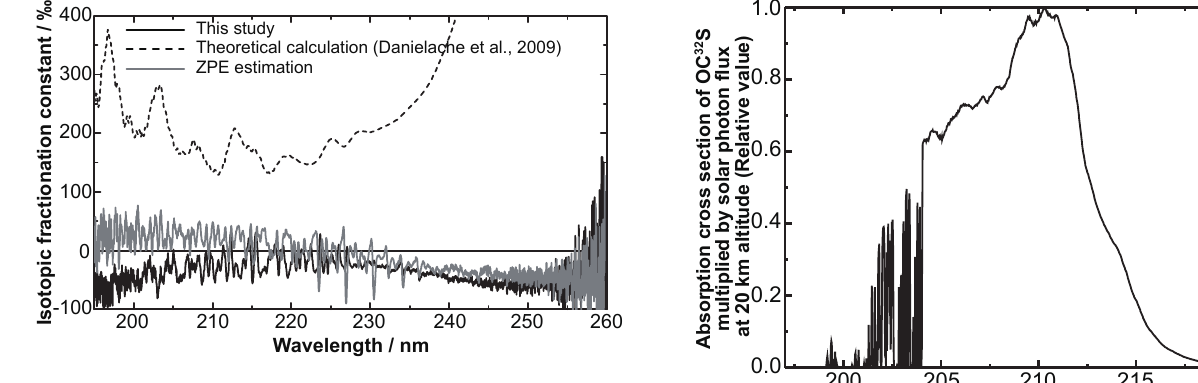
Fig. 5. Carbon isotope fractionation constant ( 13 ε ( λ )) calculated from Eq. (6) as a function of wavelength. Black line: this study; black dotted line: theoretical calculation (Danielache et al., 2009); gray line: ZPE estimation (Miller and Yung, 2000; Danielache et al., 2009).